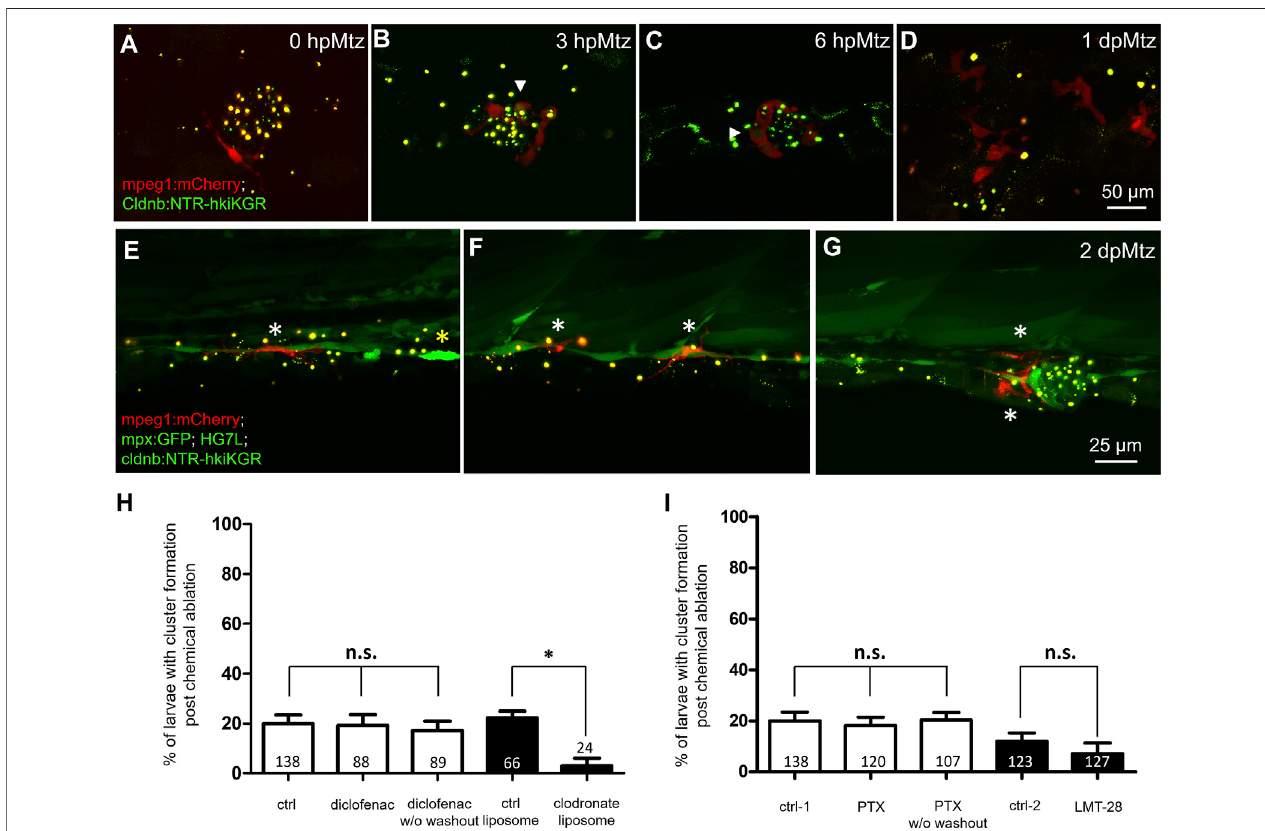
FIGURE 6 | Changes in phagocytes surrounding deteriorating neuromasts and their effects on cluster formation. Larvae from the cross of Tg (mpeg1: mCherry) (red) and Tg( − 8.0cldnb:NTR-hkiKGR;myl7:EGFP) (green) were treated with metronidazole (Mtz) as described in Figure 5 , examined and photographed at designated hours or days post-Mtz treatment (hpMtz or dpMtz). We observed the disintegration of neuromasts post-Mtz treatment (A – D) . Red macrophages (arrowheads) were recruited to engulf injured neuromasts in a dendritic cell-like shape within hours post-Mtz treatment (A – C) . The injured neuromast disappeared, but macrophages were still retained in the injured site at 1dpMtz. Please note that the macrophages became more compact round in shape with protrusions (D) . (E – G) Triple-transgenic larvae as designated were treated as described above, examined and photographed at 2 dpMz. Macrophages (red, white asterisks) were still found in the posterior laterallinesystem,eveninanewneuromast,asshownin (G) .Incontrast,onlyafewneutrophils(brightgreen,yellowasterisks)werefound.Scalesarethesameforeach rowbutareonlyshowninthefar-rightpanel. (H) Weusedlarvaefromthecrossof Et(HG7L)andTg( − 8.0cldnb:NTR-hKikGR;myl7:EGFP) .Thelarvaeweretreatedwithout (ctrl) and with 3 μ M diclofenac (with or without washout); control or clodronate liposome (H) ; or treated with different cytokine inhibitors PTX (35 μ M) or LMT-28 (10 μ M) (I) . The above-treated larvae were undergone a 12-h Mtz treatment and scored for the % of larvae with cluster formation. Data represent mean ± s.e.m. and were analyzed by one-way ANOVA, * p < 0.05. n.s.: not signi fi cant.